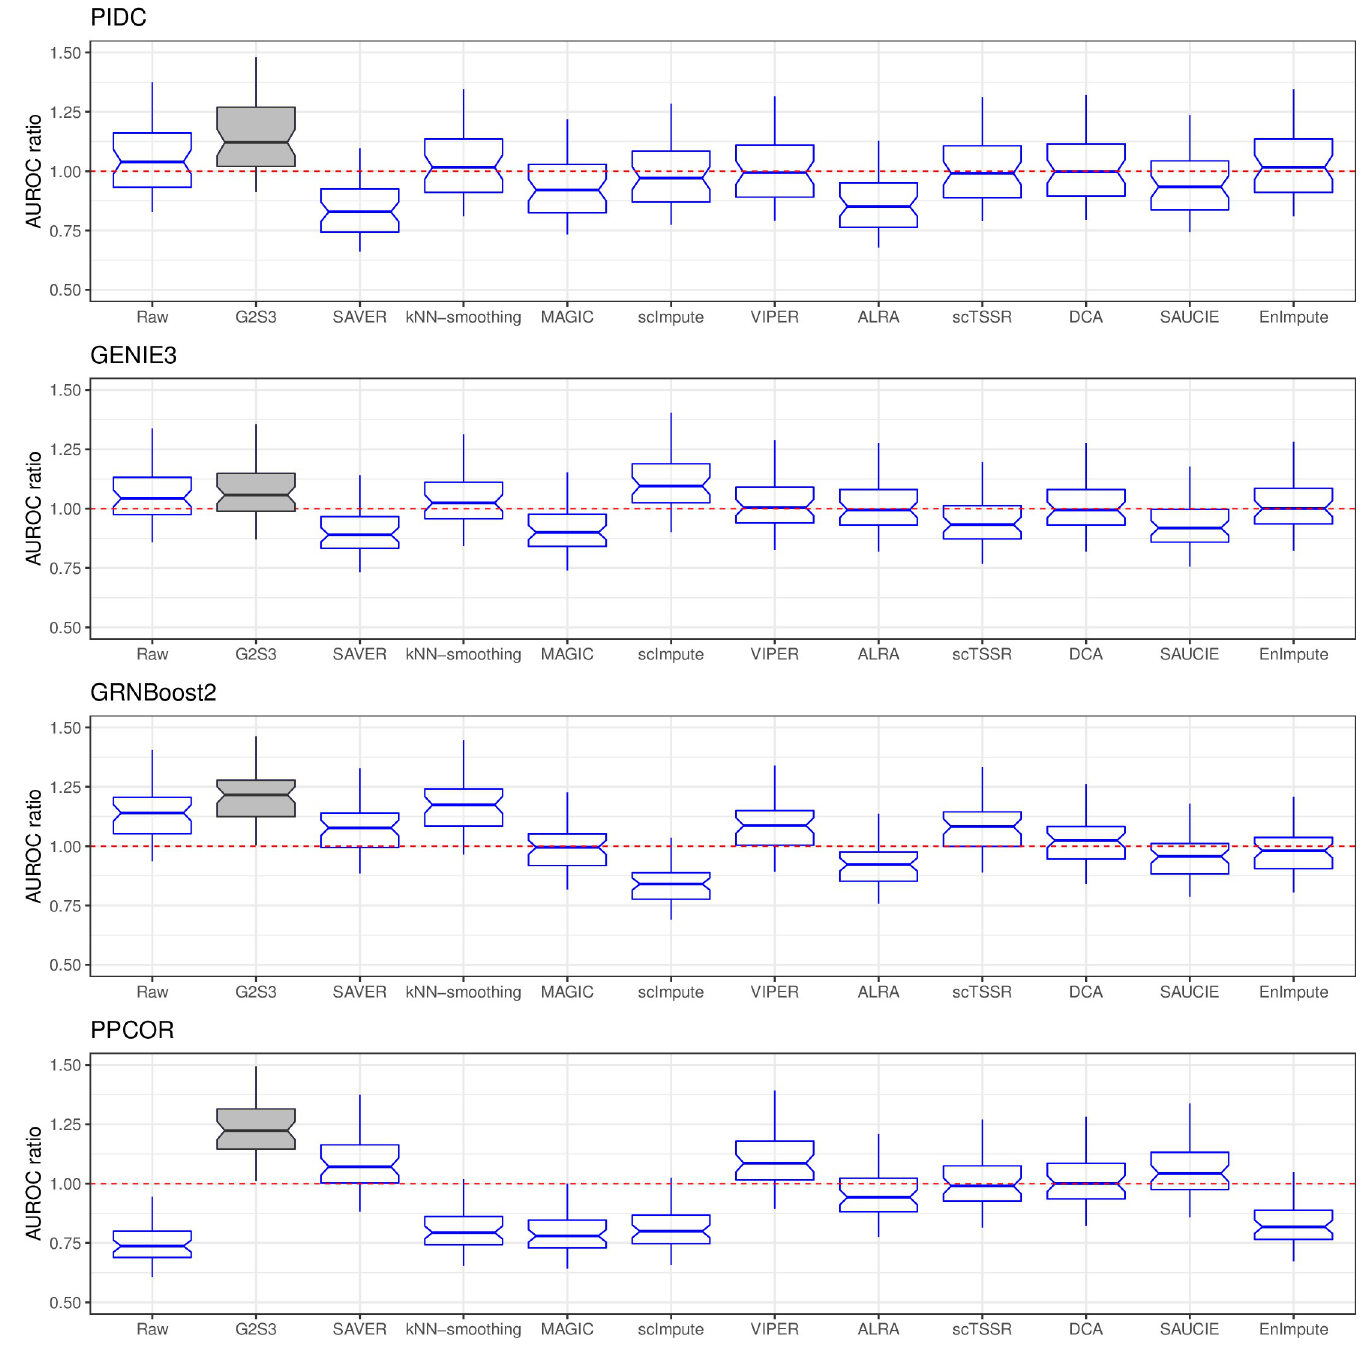
Fig 6. Performance of G2S3 in recovering gene regulatory relationships. Boxplots showing the area under the receiver operating characteristic curve (AUROC) ratios that measure the accuracy of inferred GRNs using the imputed data by different imputation methods. PIDC, GENIE3, GRNBoost2 and PPCOR are used to infer GRNs. Red line indicates the performance of a random